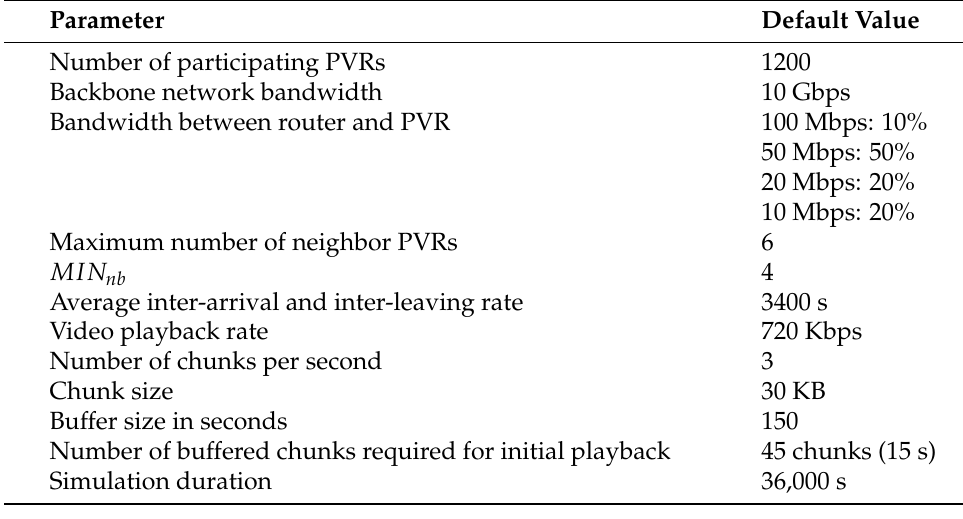
Table 2. Simulation parameters.